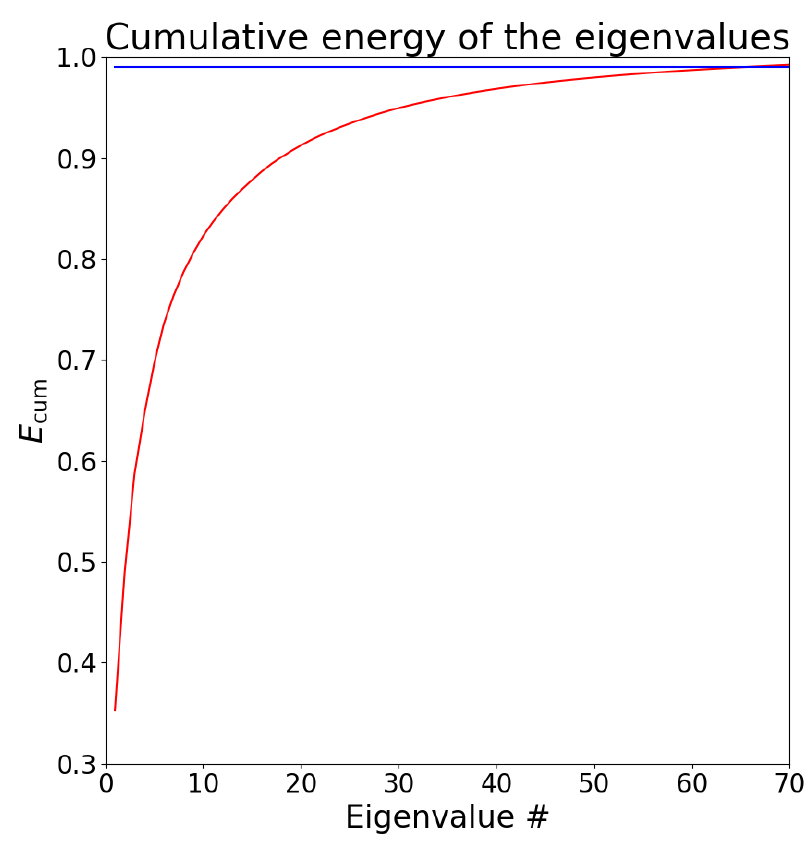
Figure 2. Cumulative energy of the eigenvalues, attaining the threshold of the 99% of the average energy of the